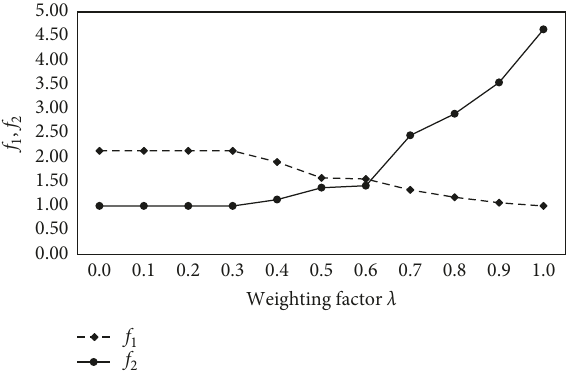
Figure 5: Solutions of f 1 and f 2 with various values of weighting factor λ for Test Network-1.